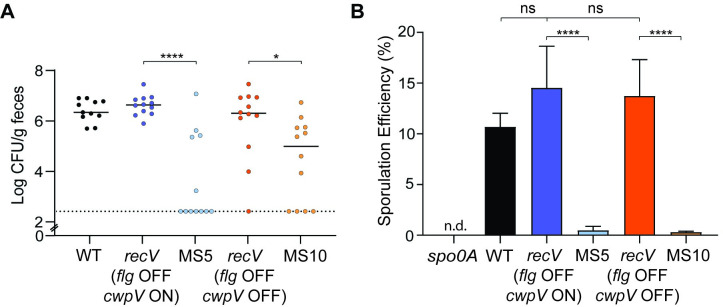
Rho is important for early colonization in a mouse model of infection and efficient sporulation.(A) Antibiotic-treated male and female C57BL6 mice were inoculated with 105 spores of the indicated C. difficile strain. CFU in feces collected at 24 hours post inoculation were enumerated. Data are combined from two independent infection studies that each included 3 male and 3 female mice for 12 total mice per strain. Symbols indicate CFU from individual animals, and bars indicate the medians. ****p<0.0001, *p<0.05 by Kruskal-Wallis test with Dunn’s post-test comparing motile suppressors to their parent strains: RT1694 (recV flg OFF cwpV ON) and MS5, RT1693 (recV flg OFF cwpV OFF) and MS10. Dotted line represents a limit of detection. (B) Sporulation efficiency was evaluated by ethanol resistance and calculated as the total number of spores divided by the total number of viable cells (spores plus vegetative). A sporulation-deficient spo0A mutant was included as a control. The means and standard deviation of four biological replicates are shown. ****p<0.0001 by one-way ANOVA with Tukey’s post-test comparing all strains. n.d.–non-detectable.